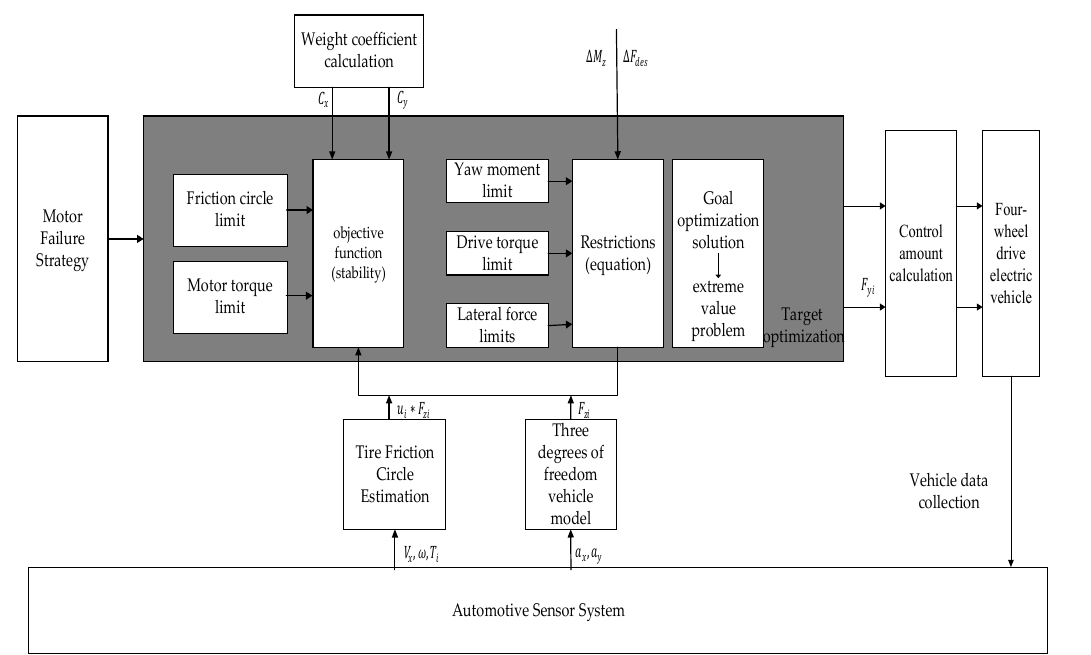
Figure 7. Overall structure of torque distribution strategy for four-wheel in-wheel motor inde- pendently driven electric vehicle. dently driven electric